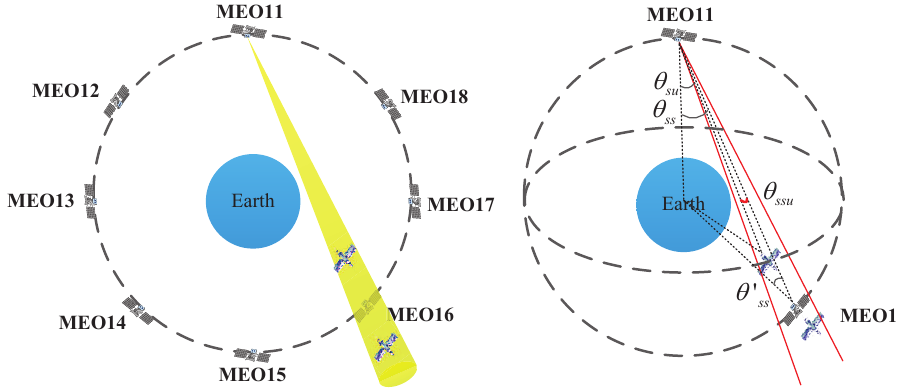
Figure 12. Geometry of users receive the signal by chance when ISLs are in normal